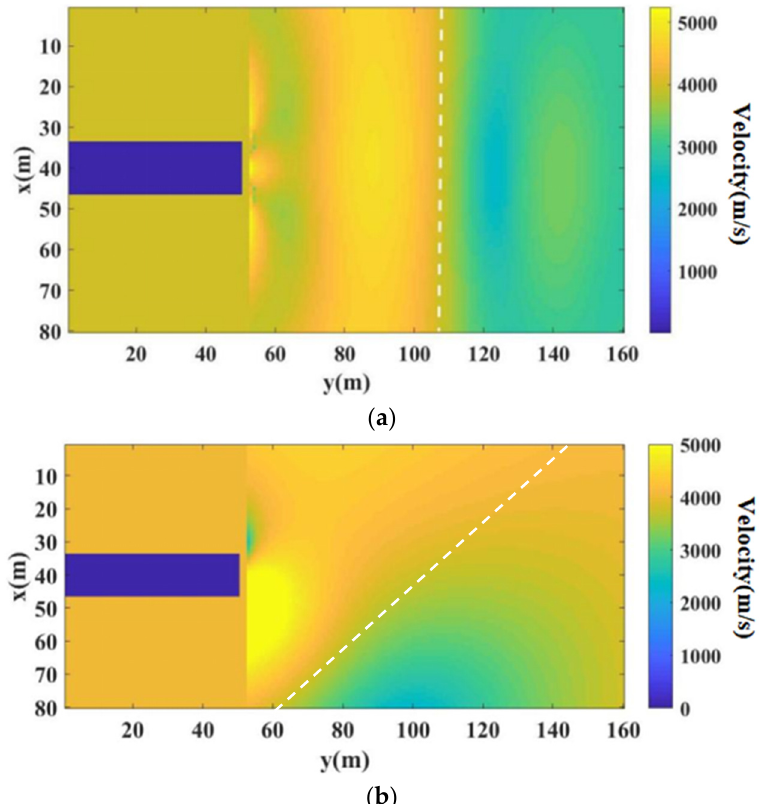
Figure 6. ( a ) FWI result of 90° lithologic interface rock wave velocity numerical model. ( b ) FWI result of 45° lithologic interface rock wave velocity numerical model.